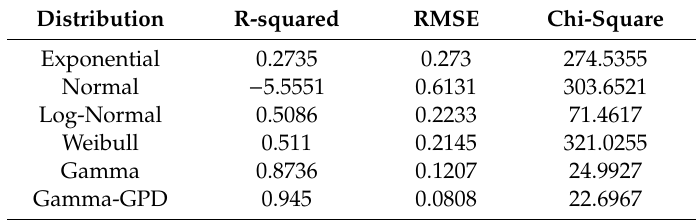
Table 4. The goodness of fit of various models under mid-century conditions (drought